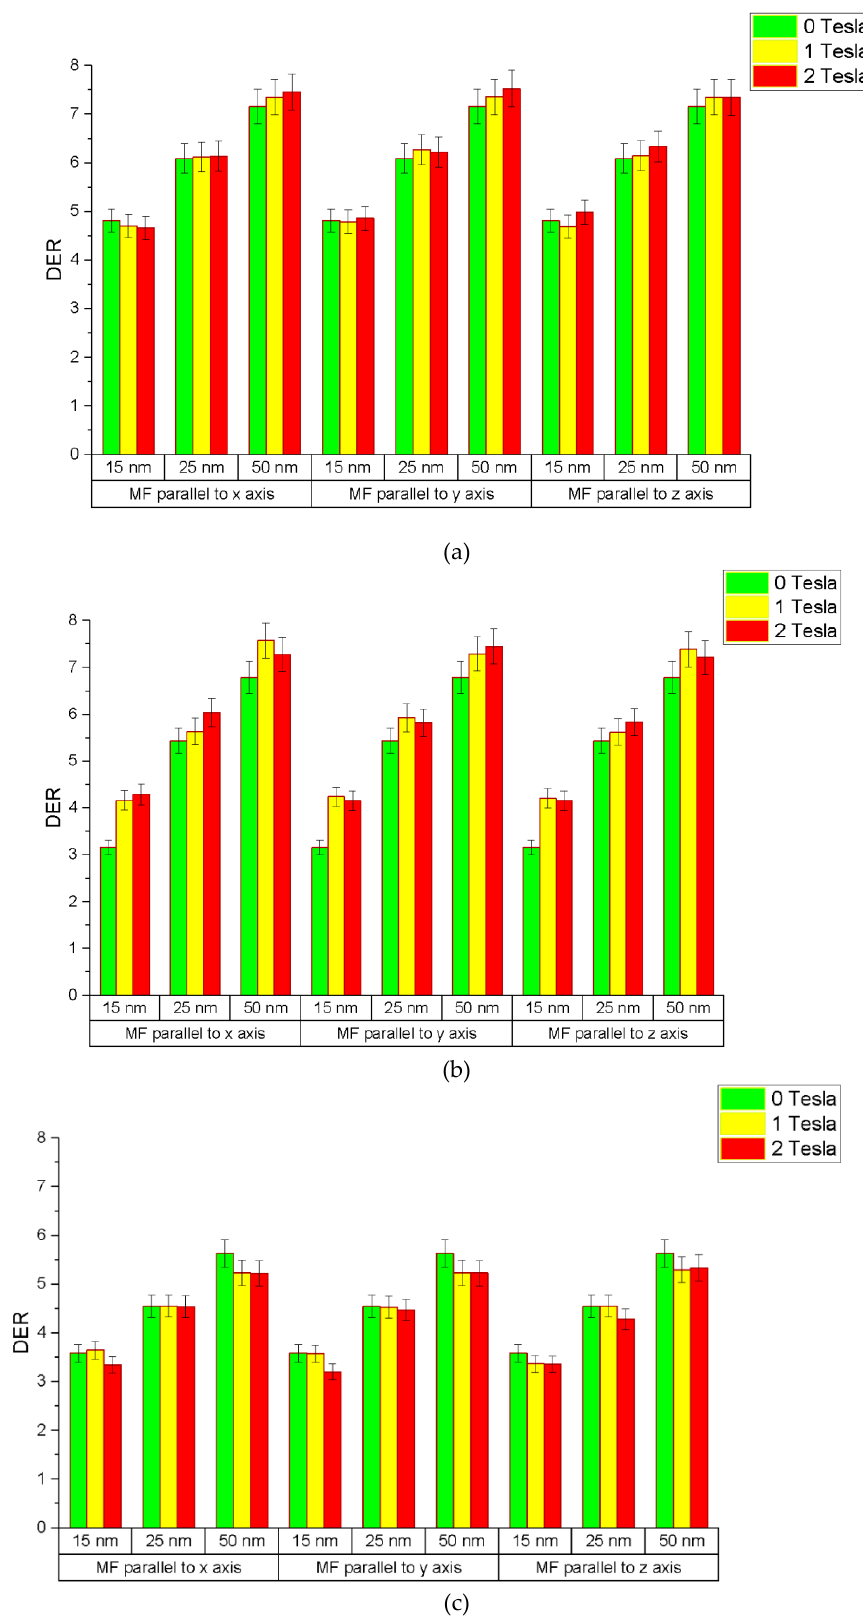
Figure 3. Relationships between the DER and simulation variables of gold nanoparticle size and magnetic field strength and orientation using photon beams with energies equal to ( a ) 50, ( b ) 100 and ( c ) 150